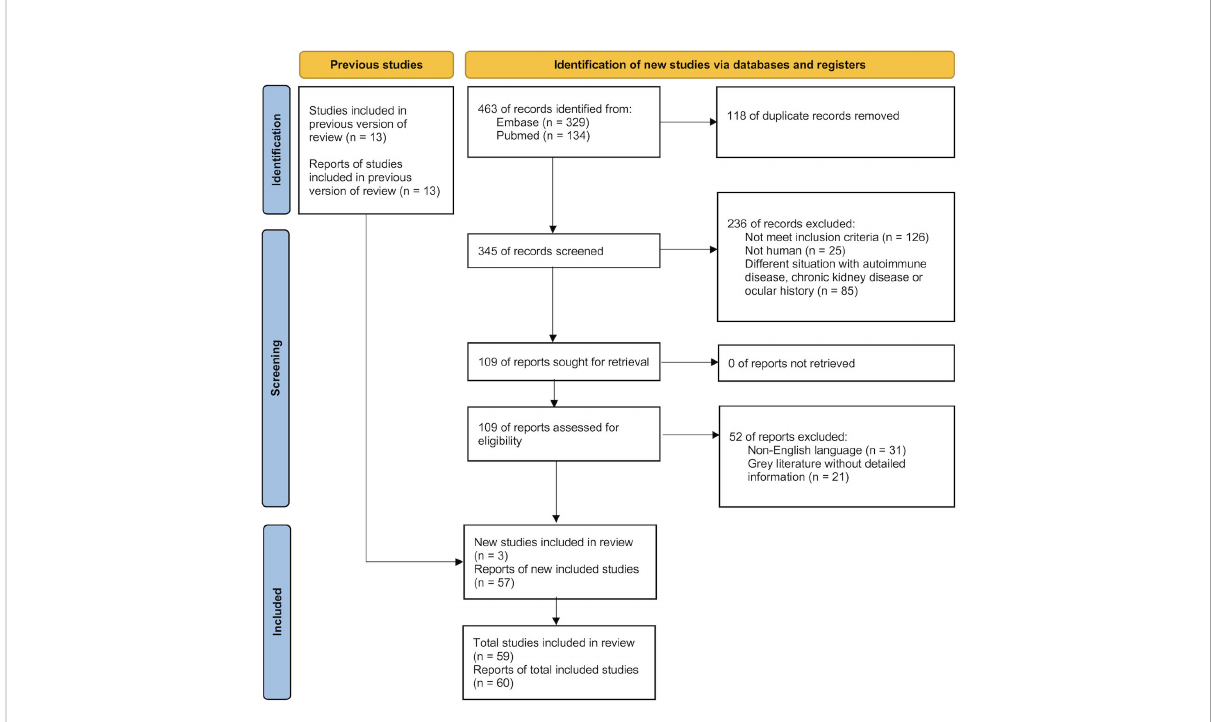
FIGURE 1 Flowchart of the systematic review with meta-analysis of the included